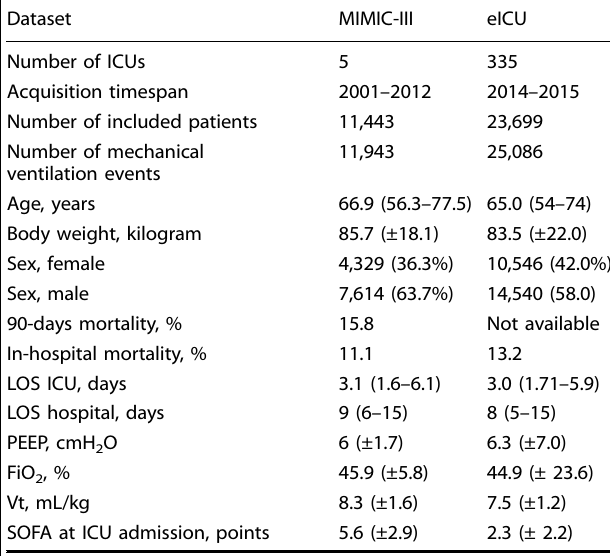
Table 1. Clinical and demographic properties of the study population.